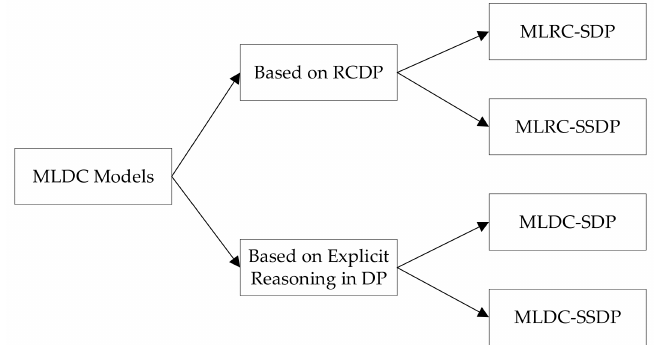
Figure 1. Structure diagram of reservoir operation models